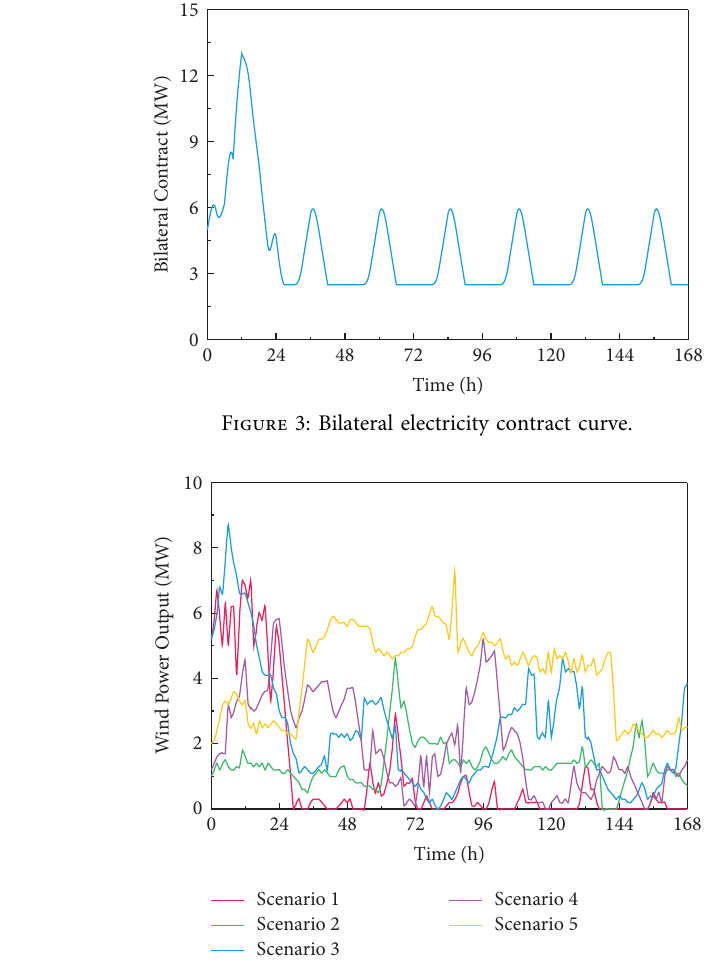
Figure 4: Wind power output in diferent